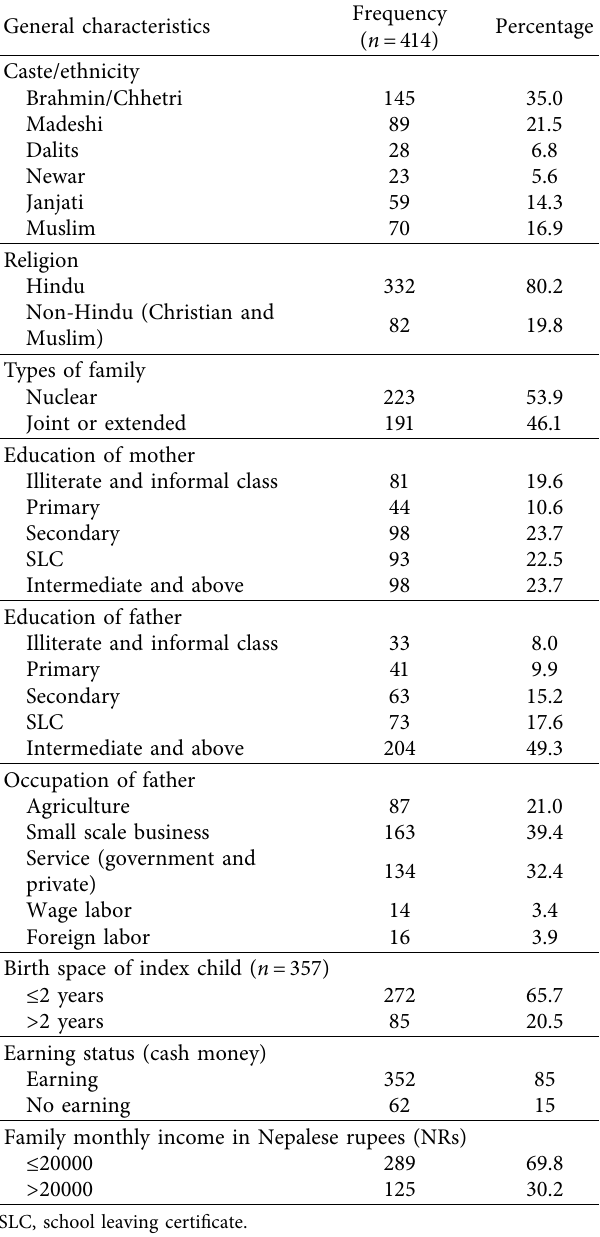
Table 1: Background related characteristics of mothers of infant with age group 6–12 months in a tertiary hospital of